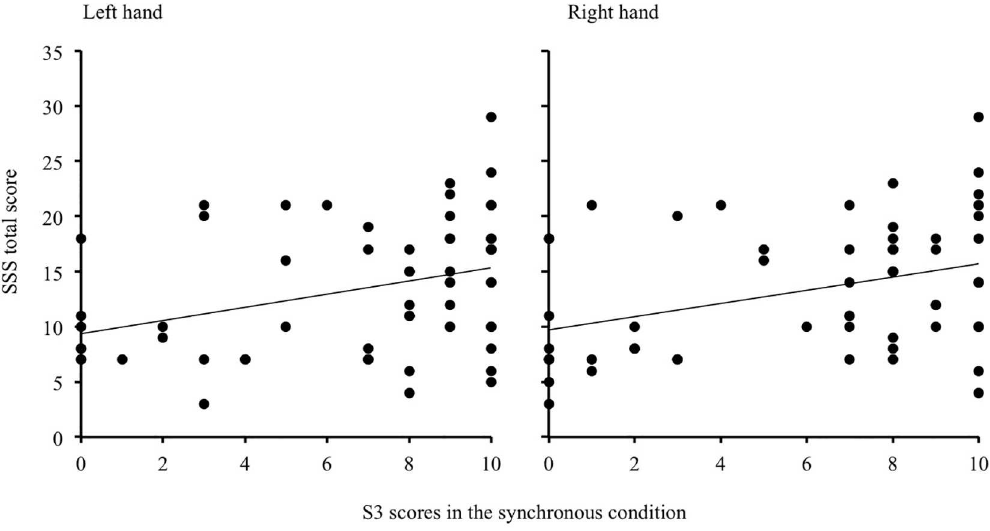
Fig 2. Correlation between S3 scores in the synchronous condition and the total SSS score. The graph shows Spearman’s correlationbetweenthe total SSS score (y-axis) and the explicit feeling of ownership(S3) after synchronous stimulation(x-axis) of the left and the right hand. The higher the degreeof sensory suggestibility, the stronger the feelingof ownershipof the rubber